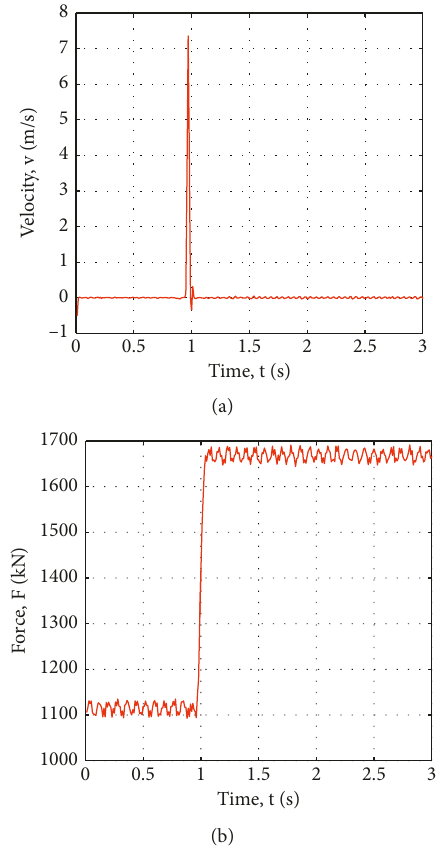
Figure 13: Impact curves. (a) Curve of measured impact velocity. (b) Curve of measured impact